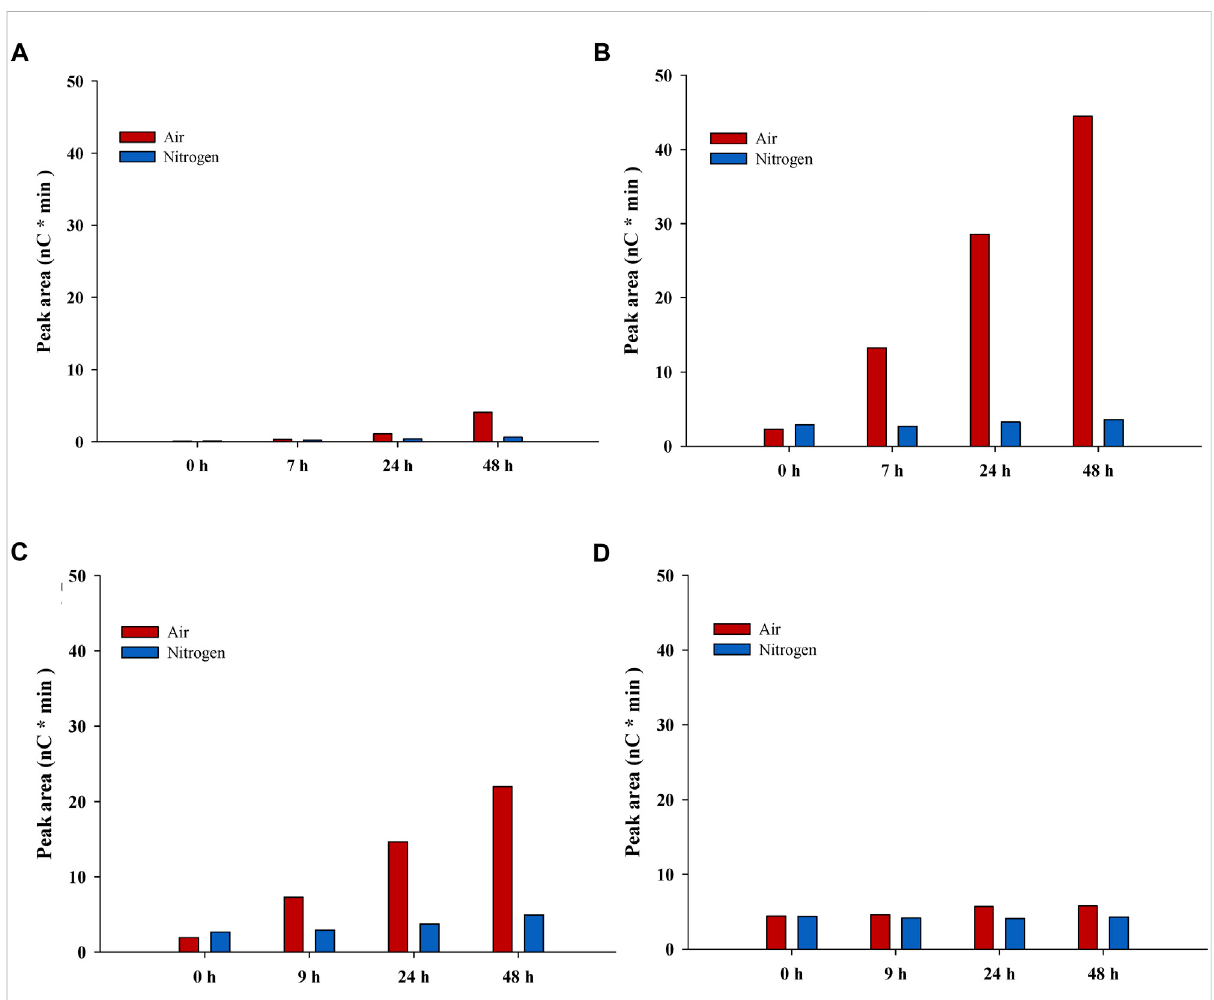
FIGURE 3 Estimation of oxidation products from LPMO-catalyzed reactions. The fi gure shows data for peakswith oxidation products from reactions with pretreated solids in buffer (A) and (B) and with Avicel in pretreatment liquid (C) and (D) . Left-hand panels (A) and (C) show the tentative C1 product, while right-hand panels (B) and (D) show the tentative C4 product. Red bars, reactions with air; blue bars, reactions with N 2